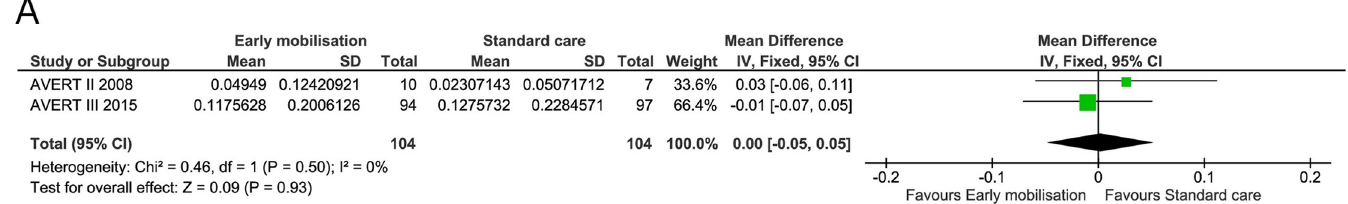
Fig 10. Comparison of early mobilisation versus standard care–Quality of life at maximal follow-up. Fig 10 A. Forest-plot showing the results from the fixed-effect meta-analysis of the outcome quality of life at maximal follow-up with subgroup divided according to risk of bias.